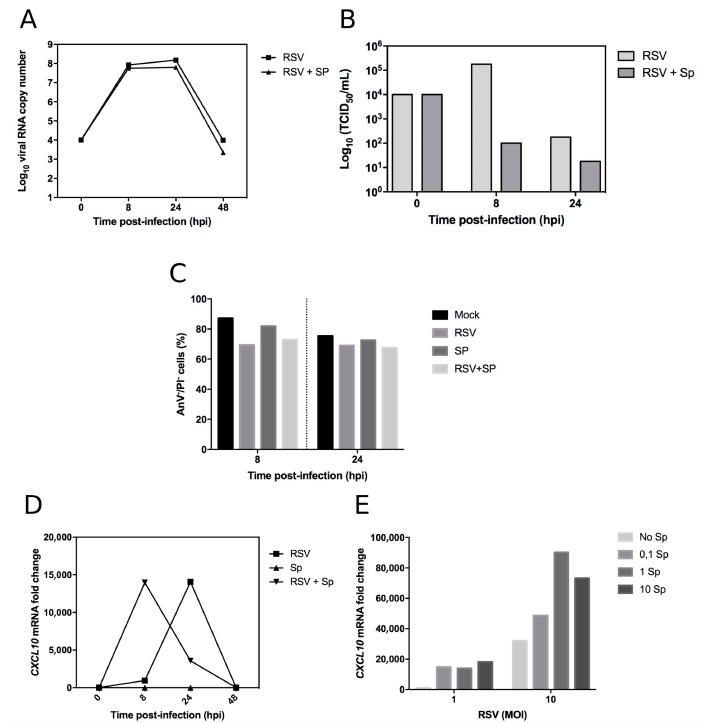
Figure 2. Characterization of RSV/ Sp mixed infection in human monocyte-derived macrophages (MDMs). Human MDMs were infected by RSV at an MOI of 1. After 4 h of viral infection, cells were mock-infected or infected by Sp at 1 CFU/cell. Encapsulated Streptococcus pneumoniae serotype 14 was obtained from the National Reference Center for Streptococci (Department of Medical Microbiology, Aachen, Germany). Pneumococci were opsonized in anti-pneumococcal immune serum and incubated for 30 min at 37 ◦ C prior to infections for all experiments. MDM cells showed significant loss of viability following overnight incubation with S. pneumoniae , and gentamicin (10 µ g/mL) was therefore added to all wells at the 2-h time point to prevent bacterial overgrowth and loss of cell